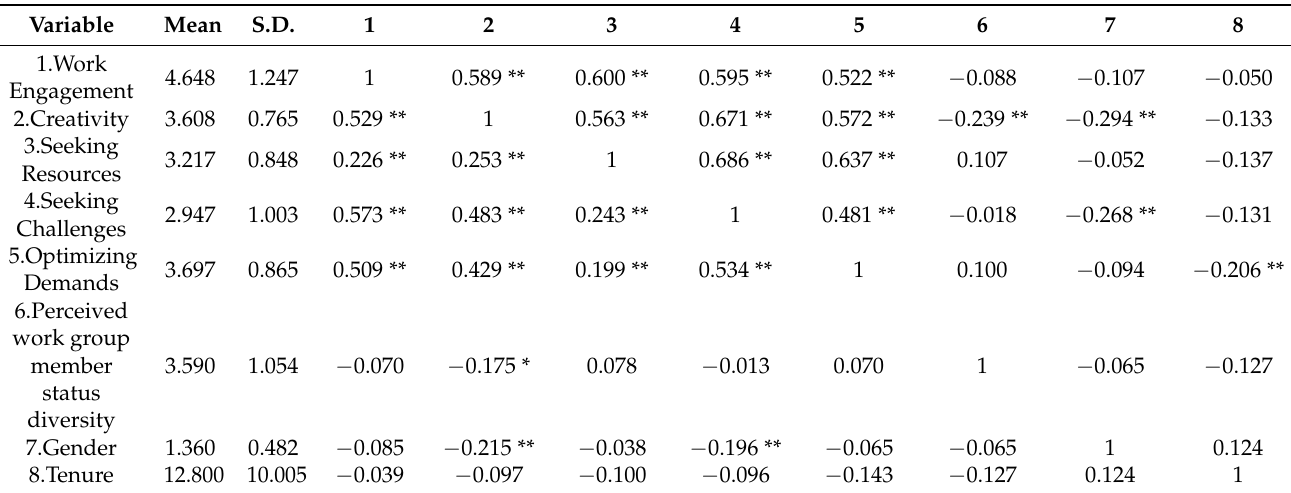
Table 1. Mean, SD, and within-level (below the diagonal) and between-level (above the diagonal) correlations of the study variables (N =